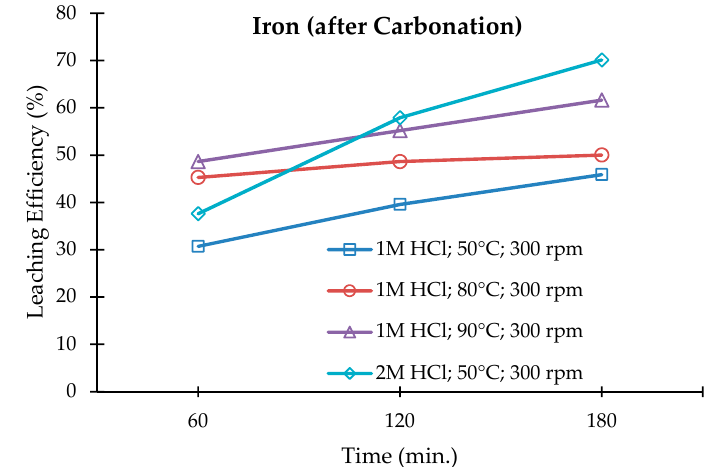
Figure 12. Leaching efficiency of magnesium from a carbonated olivine depending on concentration of hydrochloric acid and temperature for the fraction 20–63 µm.